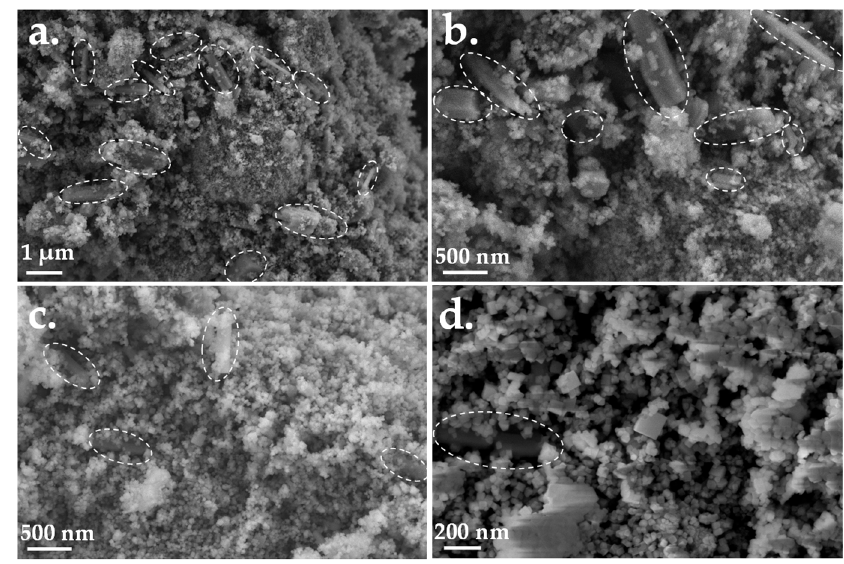
Figure 3. SEM micrographs of STO_15_SCO ( a , b ) and STO_24_SCO ( c , d ).